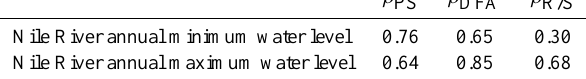
Table 2. Results of long-range persistence analysis for the Nile River records (622–1900 AD) of low- and high-water levels in Fig. 7; the three different techniques are power-spectral analy- sis (PS), detrended fluctuation analysis (DFA), and rescaled-range analysis (R/S). β PS β DFA β R/S